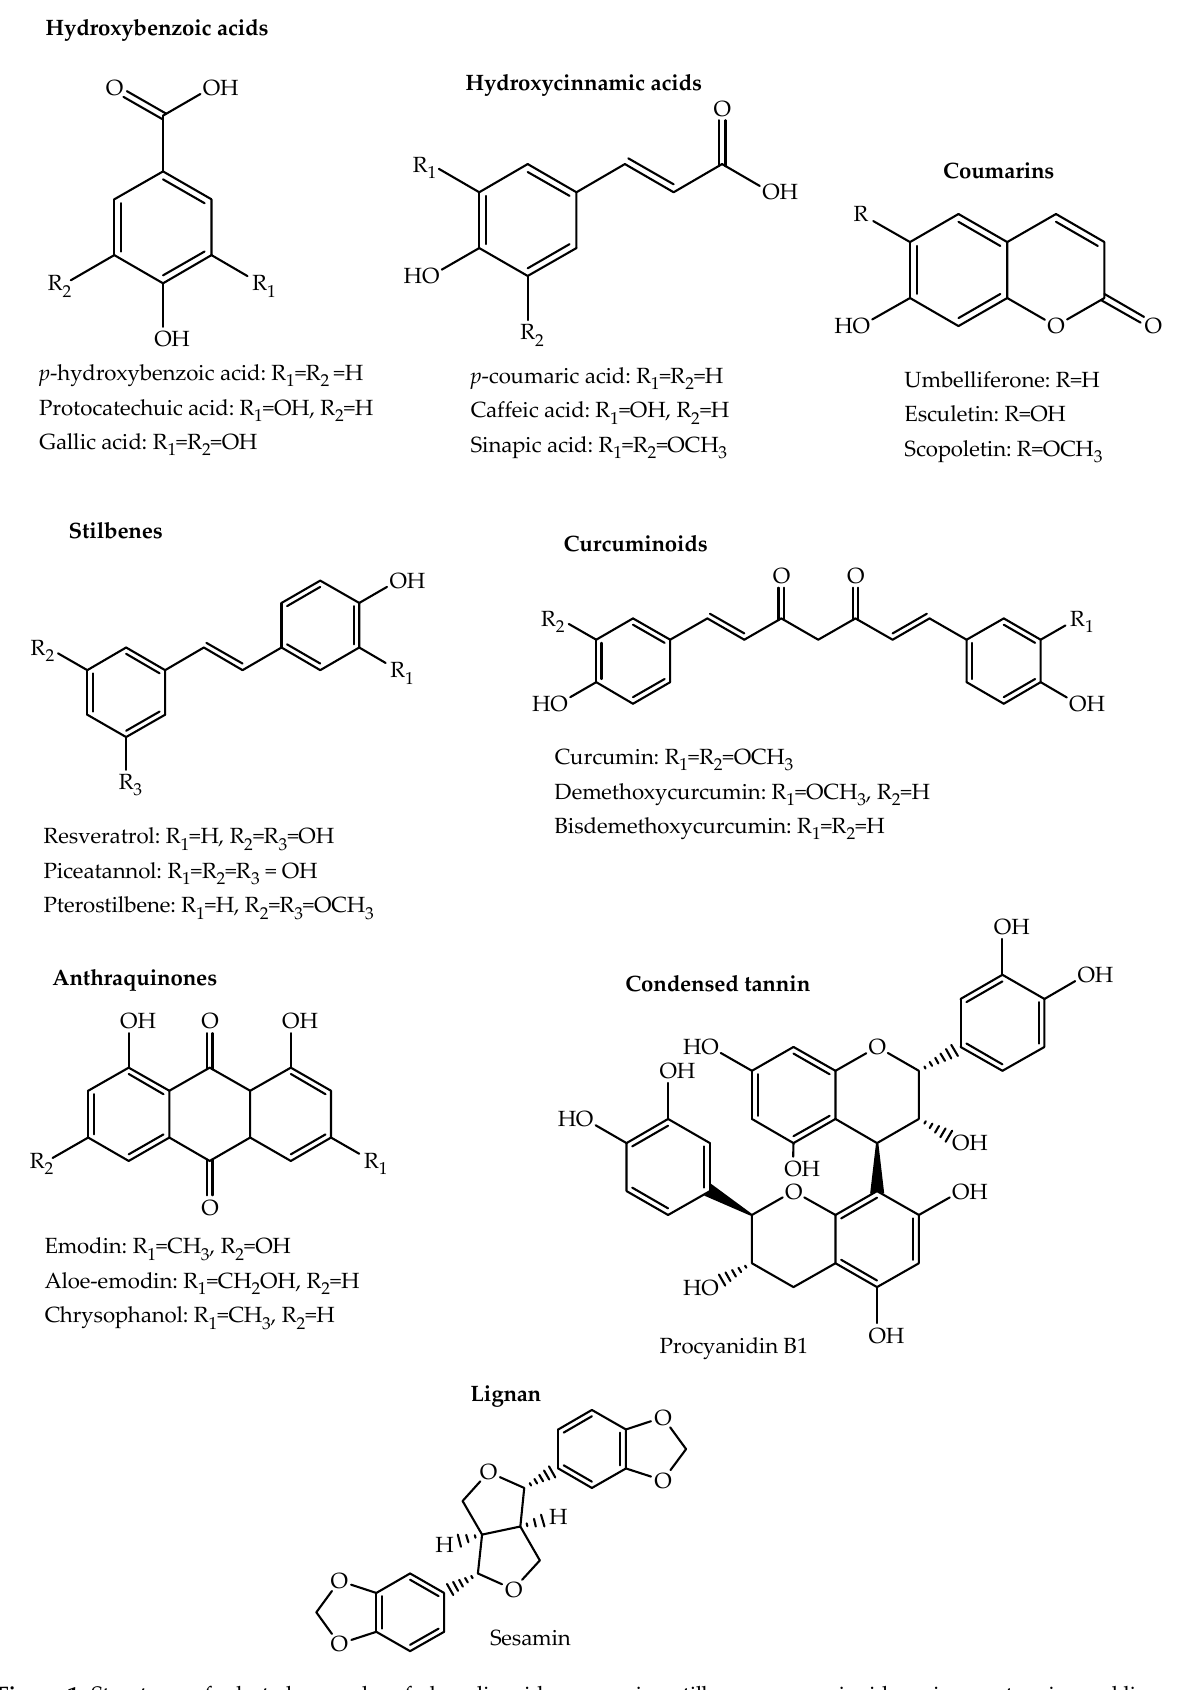
Figure 1. Structures of selected examples of phenolic acids, coumarins, stilbenes, curcuminoids, quinones, tannins and lignans.